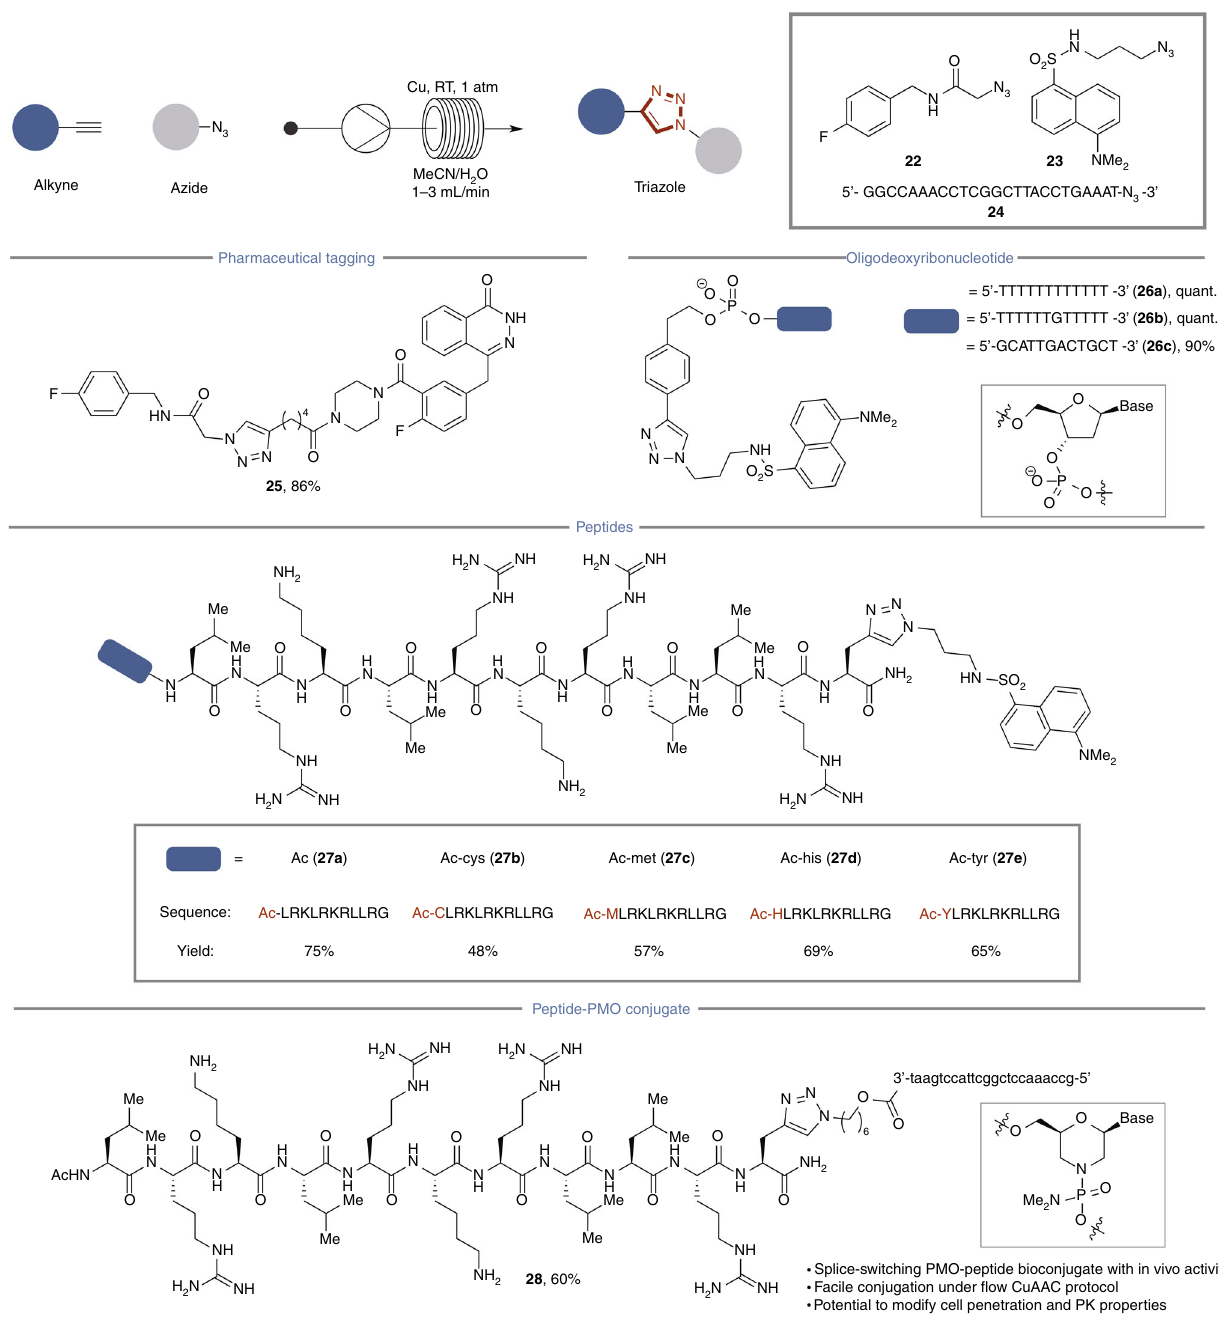
Fig. 4 Alkyne scope of the fl ow CuAAC process. For each product number (in bold), data are reported as percent isolated